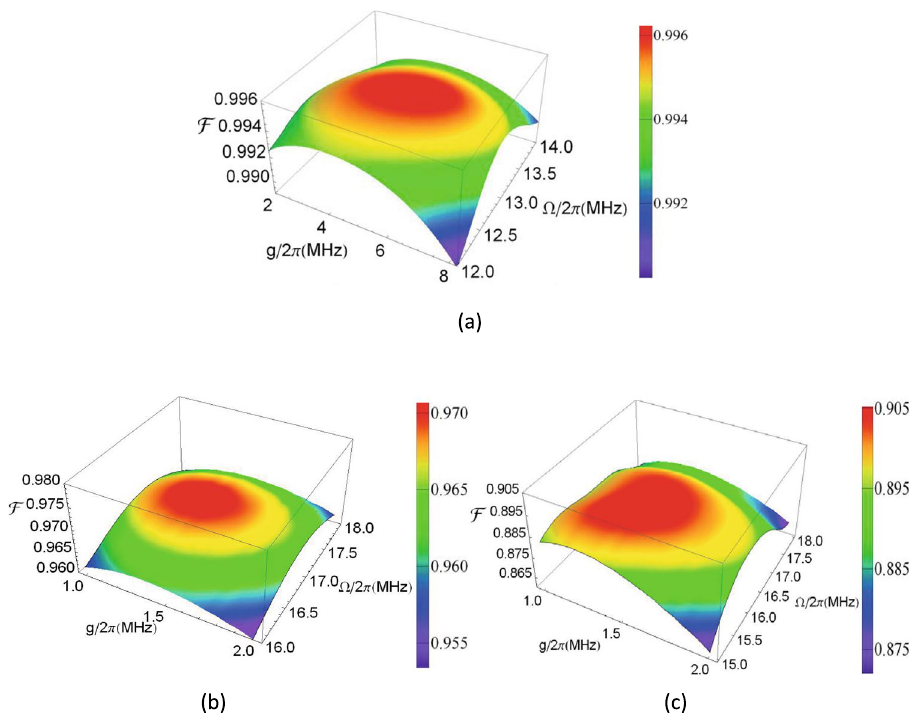
Figure 3. Fidelity for the quantum state transfer for g /2 π and Ω/2 π . ( a ) Fidelity for d = 3. ( b ) Fidelity for d = 4. ( c ) Fidelity for d =